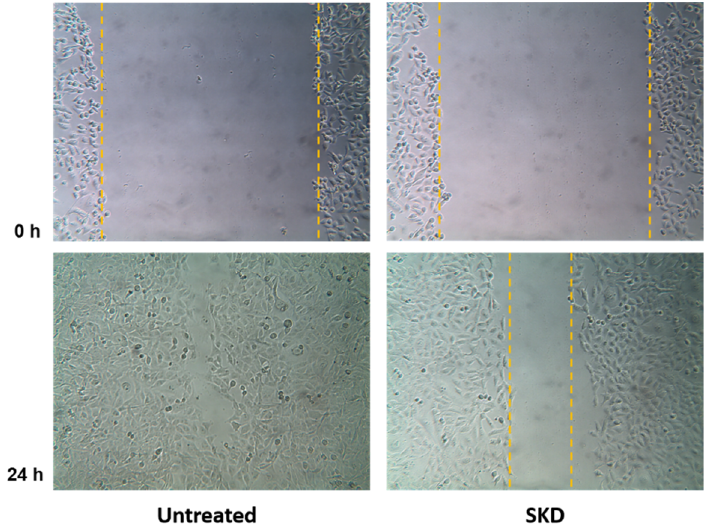
Figure 6. Inhibitory effect of SKD on MDA-MB-231 cell migration detected by a wound-healing assay. MDA-MB-231 were treated with vehicle or with SKD compound. Representative photomicrographs were obtained at 0 and 24 h. Percent relative migration values are the average of three independent experiments. Dotted lines show the area occupied by the initial scraping for 0 h, and the wound edge after 24 h.